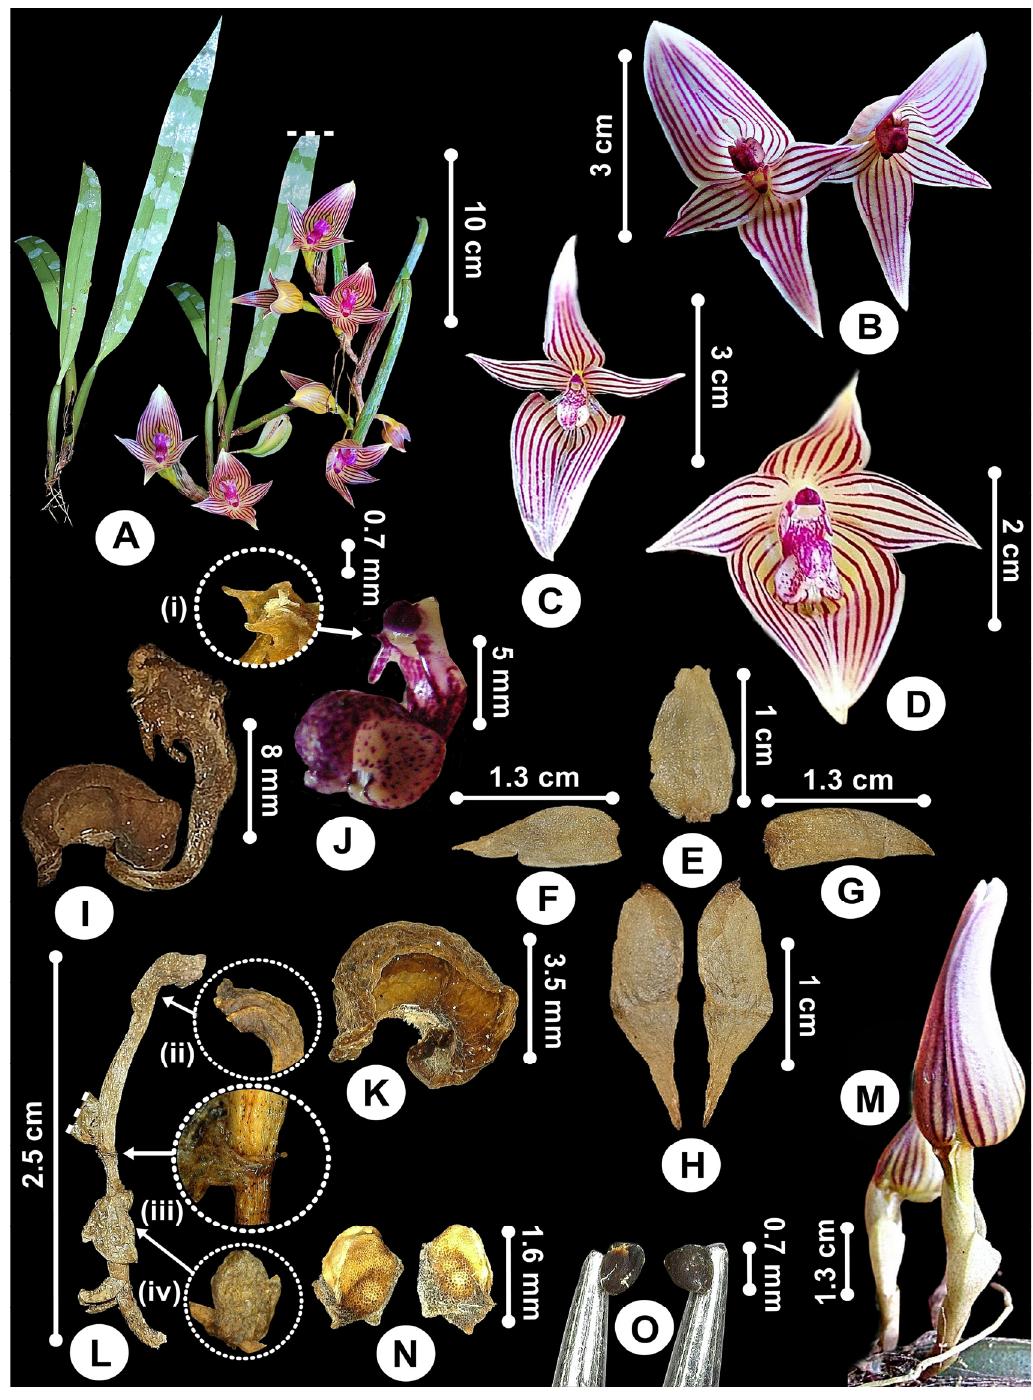
Figure 2. Bulbophyllum abangjoei sp. nov. ( A ) Plant; ( B ) non-resupinate and white flower of the holotype; ( C ) upturned flower of the holotype showing lateral sepals adherent at lower margins; ( D ) upturned flower of the paratype showing pale yellowish flower; ( E ) dorsal sepal; ( F , G ) petals; ( H ) lateral sepals; ( I ) column + labellum showing labellum base hinged on a thin ligament to the column foot; ( J ) column + labellum, showing upcurved apex of the labellum and acute (i) and elliptic-oblong margins of the stelidia; ( K ) lateral view of the labellum; ( L ) peduncle + pedicel + ovary, showing (ii) angular-crest ovary (ii), basal node pedicel coinciding with floral bract attachment (iii), and ovate bract (iv); ( M ) one-flowered inflorescence showing amplexicaul floral bracts; ( N ) anther-cap; ( O ) pollinia. E-H, I, K, L, N, O are spirit-preserved specimens.